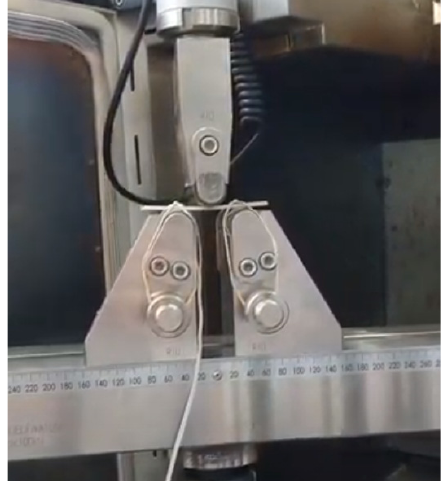
Figure 2. Three ‐ point bending set up for cyclic loading of CFRP, GFRP, and hybrids. Figure 2. Three-point bending set up for cyclic loading of CFRP, GFRP, and hybrids. Samples were cycled up to maximum loading then cycled down to 10% of maximum Cyclic loading under a three-point bending setup was used to determine stiffness force, for 4,000, 100,000, and 1,000,000 cycles. The three test cycles are undertaken to ex ‐ degradation. Stiffness degradation is measured for both low cycle high amplitude and high amine the composite laminates stiffness degradation at different failure stages. Strain cycle low amplitude